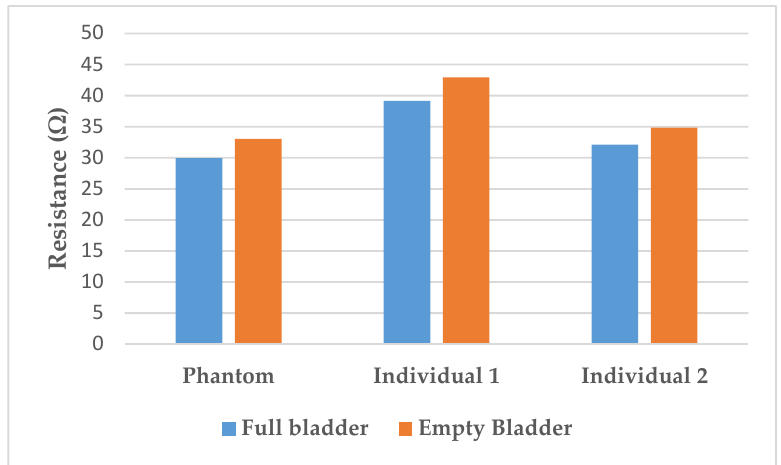
Figure 8. Resistance variation between full and empty bladder on the phantom compared to on the individuals.